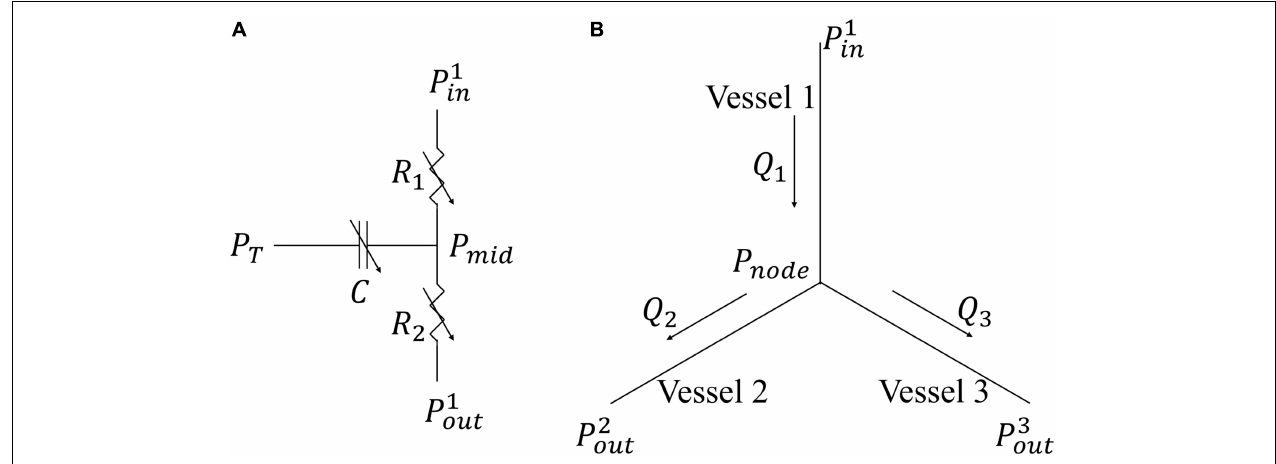
FIGURE 2 | Flow models in a single vessel and vessel bifurcation. (A) Electrical non-linear analog of the segment lumped model; (B) Single bifurcation three-vessel